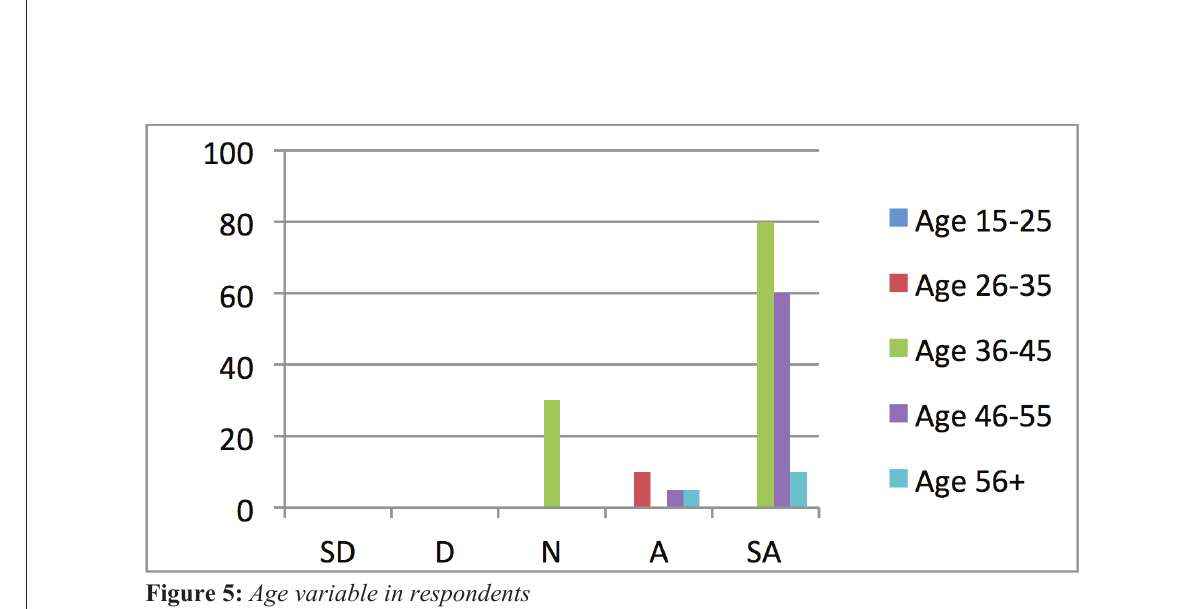
Figure 5: Age variable in respondents